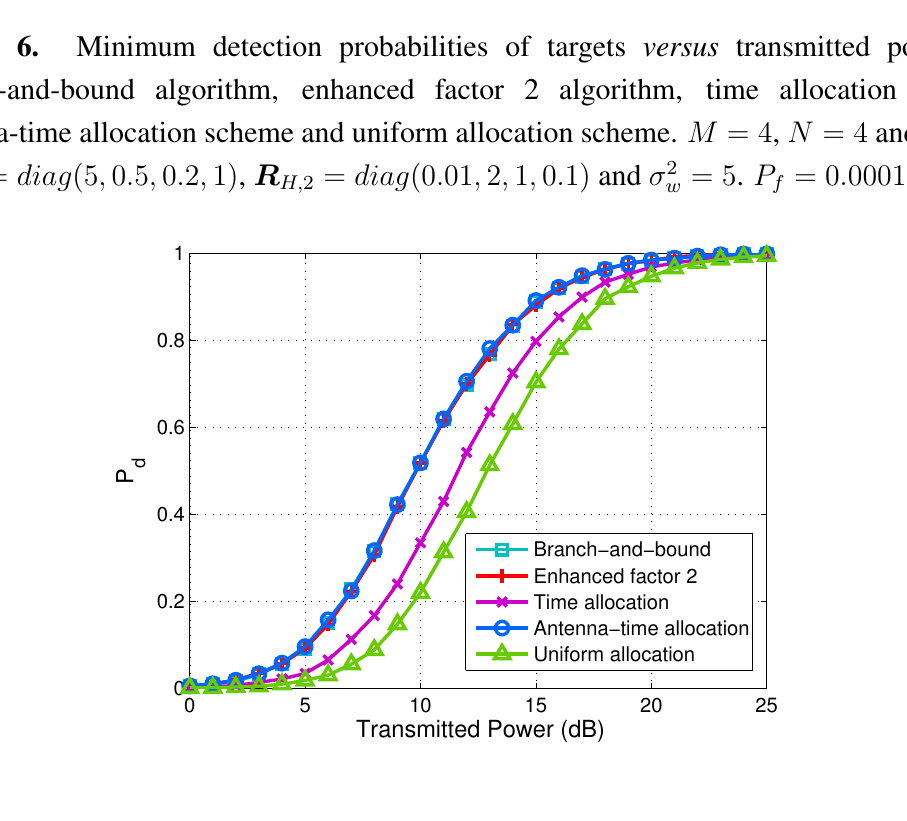
Figure 7. Minimum detection probabilities of targets versus target radar cross-section (RCS) fluctuations via five allocation methods. M = 4 , N = 4 , K = 2 , transmitted power P = 5 = 5 . P = 0 . 0001 dB and σ 2 f w